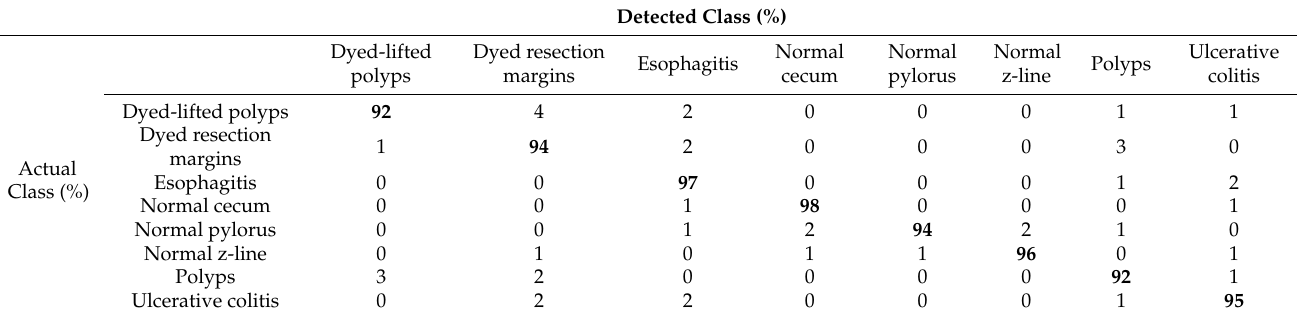
Table 7. Confusion matrix of our proposed model (Mobilenetv2).